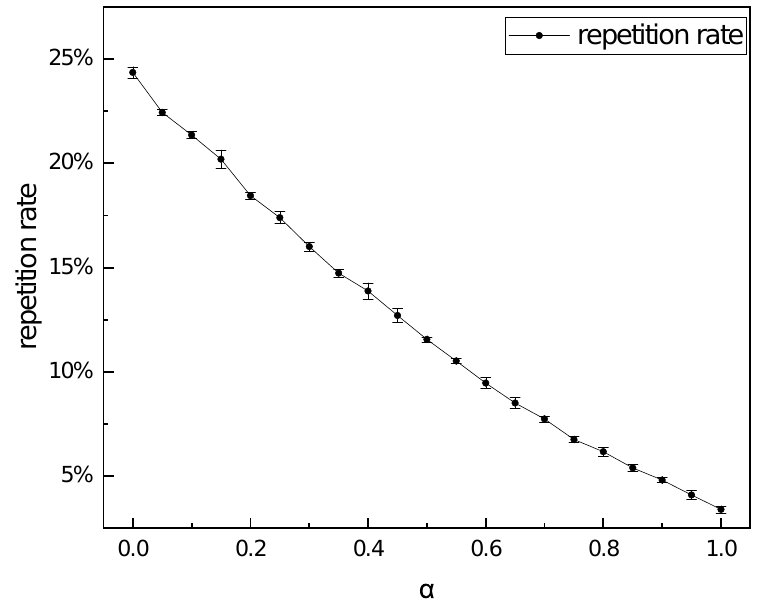
Figure 5. The repetition rate of 10 7 passwords with different hyperparameter α .